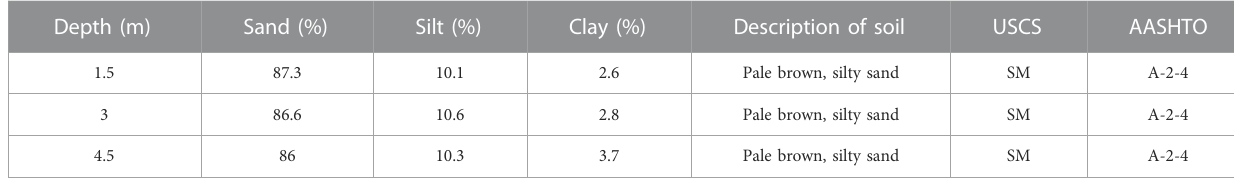
(Table 1). The tested soil is known as silty sands (SM) by the use of the uni fi ed soil classi fi cation system (USCS).